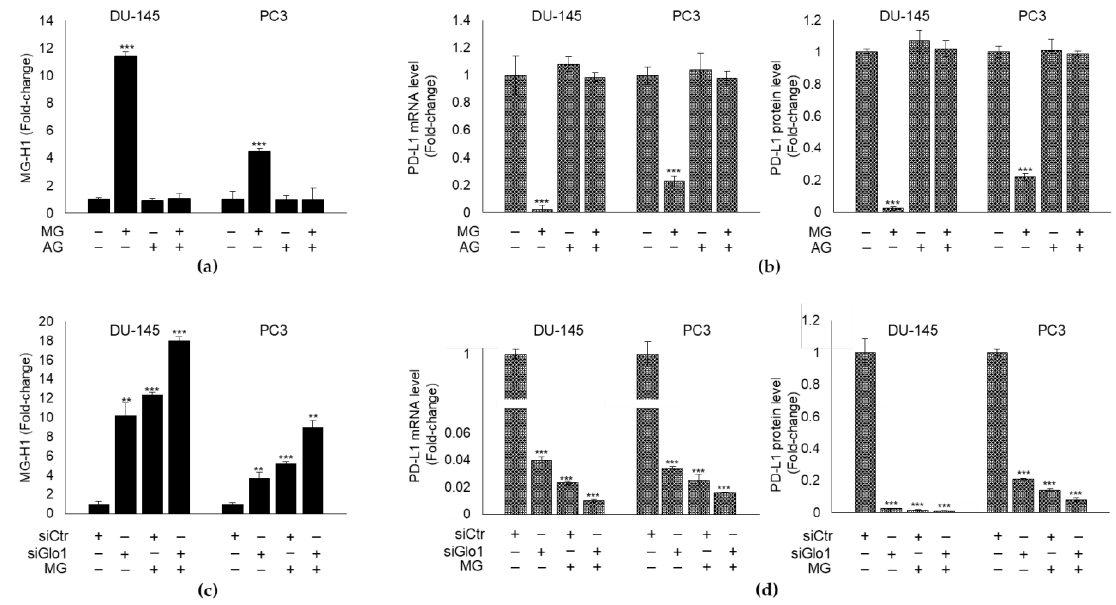
Figure 3. Effect of methylglyoxal (MG) on MG-derived AGE, MG-H1, and PD-L1 expression in mPCa cells. MG, at the concentration of 10 µ M, was administrated to DU-145 and PC3 cells for 48 h and MG-H1 levels were measured by Western blot ( a ) and a specific ELISA kit ( b ). The expression of PD-L1 was evaluated at ( c ) mRNA level by RT-qPCR, and protein level by ( d ) Western blot and ( e ) a specific ELISA kit. The molecular weight markers associated with the blots are reported in Figure S5. The histograms indicate mean ± SD of three different cultures, and each was tested in duplicate. *** p < 0.001 significantly different from untreated control cells.